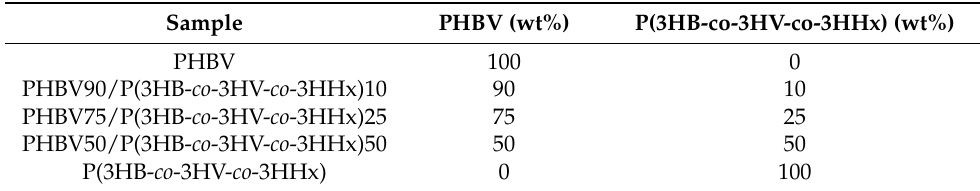
Set of formulations prepared according to the weight content (wt%) of poly(3- hydroxybutyrate- co -3-hydroxyvalerate) (PHBV) and poly(3-hydroxybutyrate- co -3-hydroxyvalerate- co -3-hydroxyhexanoate) [P(3HB- co -3HV- co -3HHx)]. Sample PHBV (wt%)